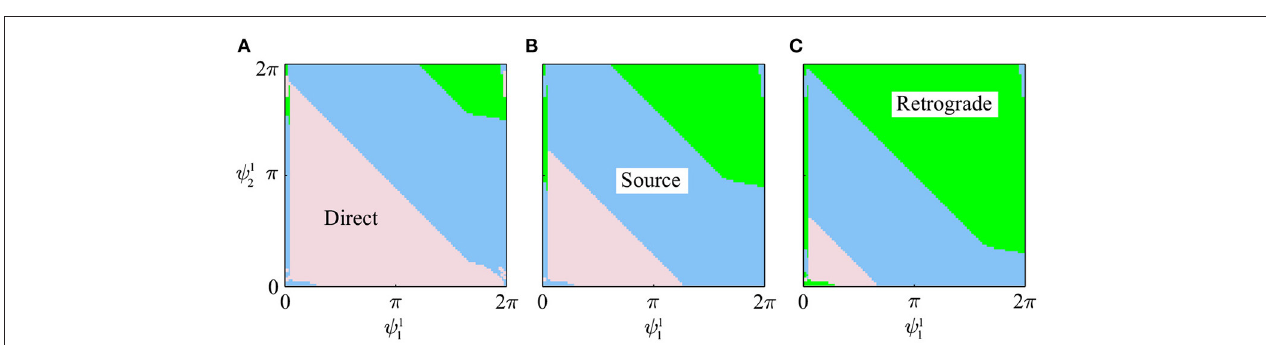
FIGURE 4 | Relative phases for 9 1 of periodic solutions: (A) shown in ψ 1 1 - ψ 1 2 - ψ 1 3 space, (B) projected to a plane parallel to the ψ 1 1 - ψ 1 2 plane, and (C) projected to a plane parallel to the ψ 1 2 - ψ 1 3 plane. Thick colored lines and thin black lines represent simulated and analytic solutions, respectively. Points a, b, and c are used to show footprint diagrams in Figure 6 .